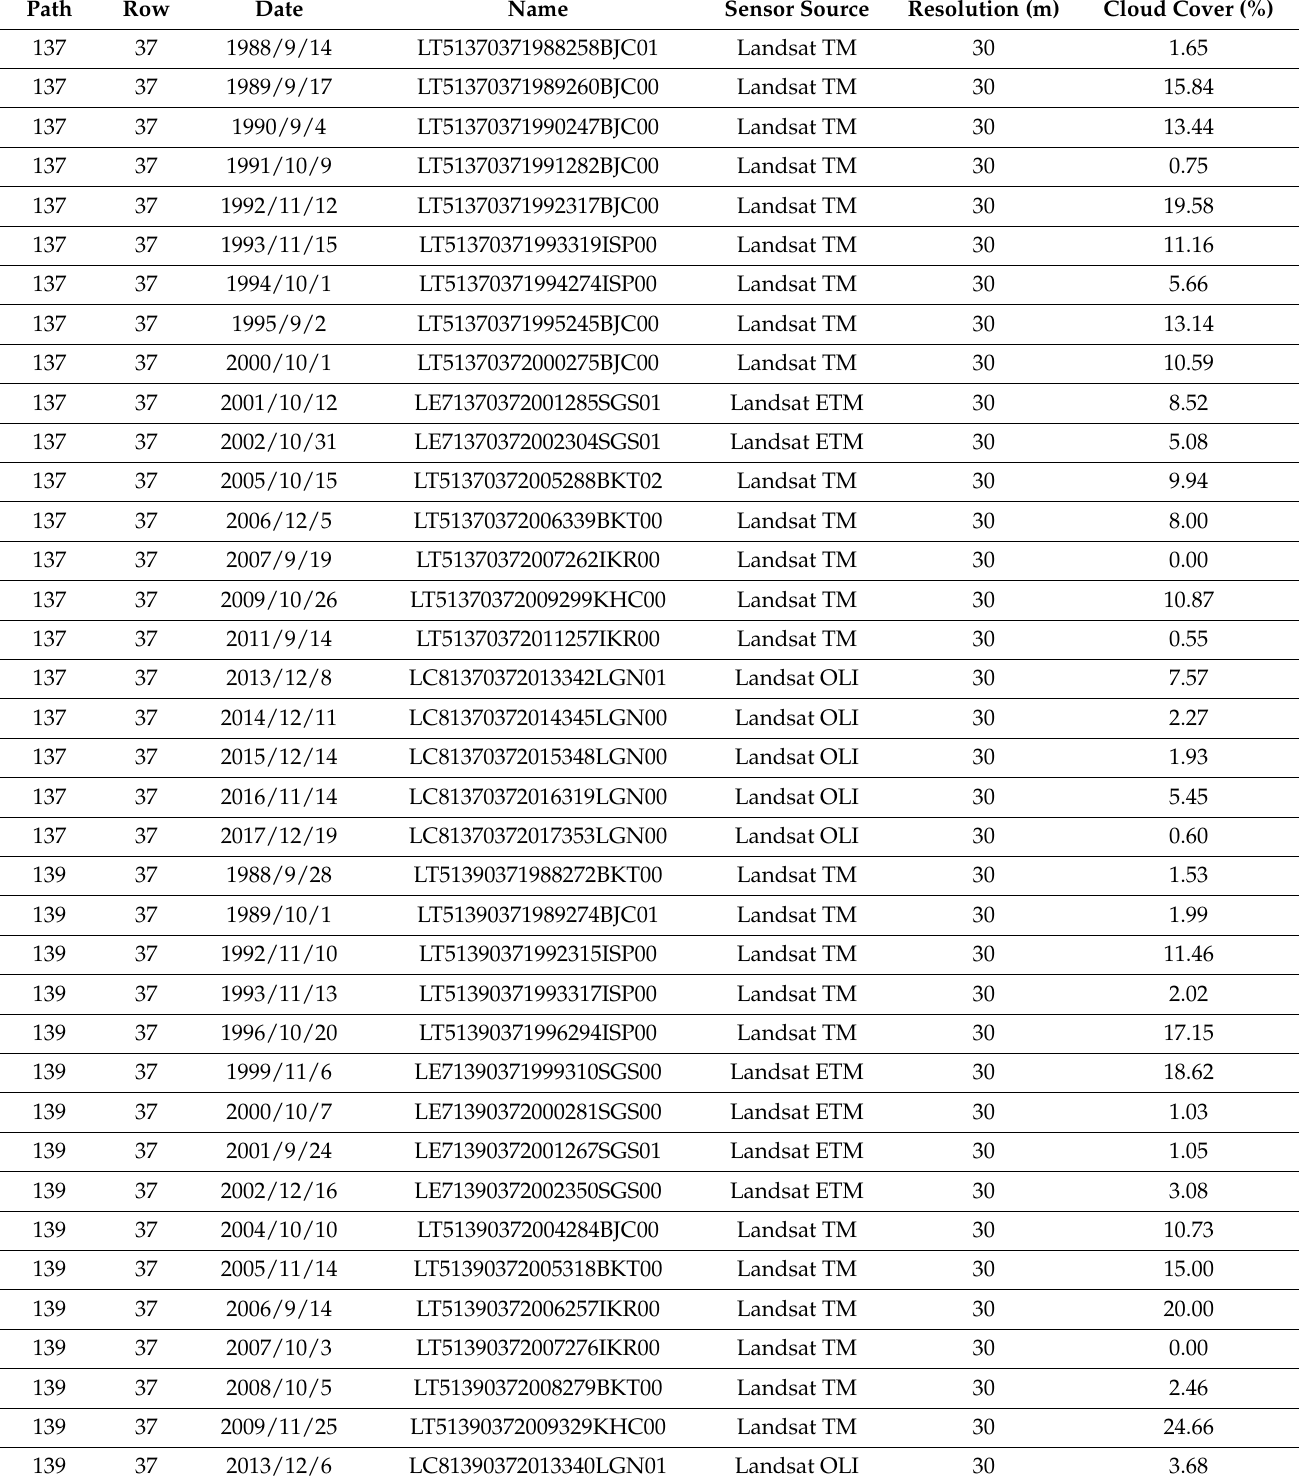
Table 1. RS data used to derive lake